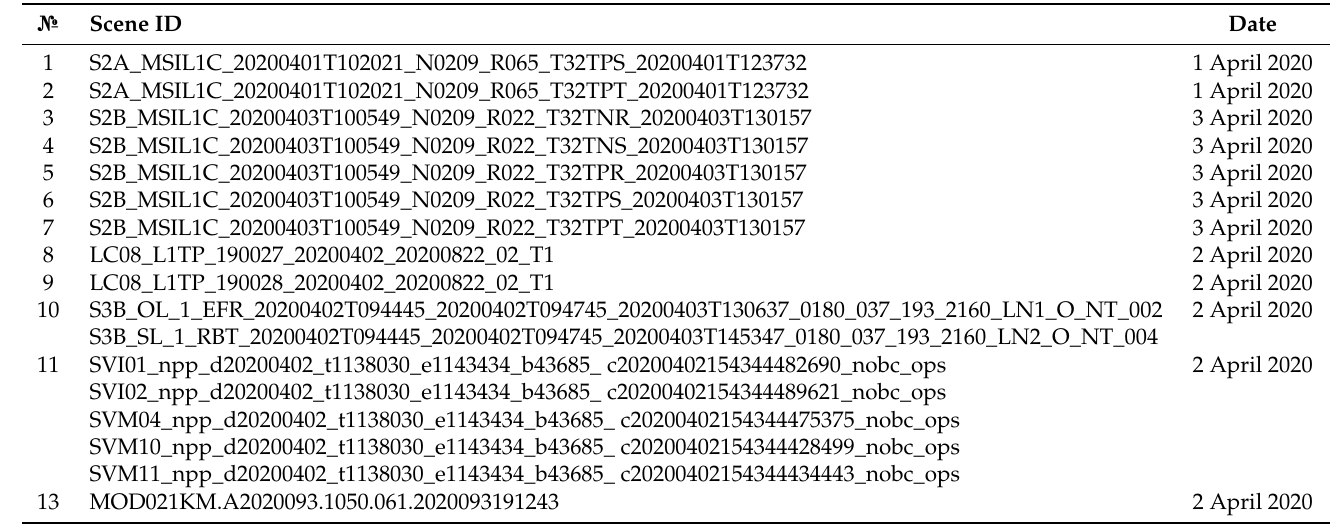
Table A1. List of Sentinel-2 MSI, Landsat 8 OLI, Sentinel-3 SLSTR/OLCI, Suomi-NPP VIIRS and Terra MODIS data, which were used for the inter-comparison of the LAMSU SCF estimates for